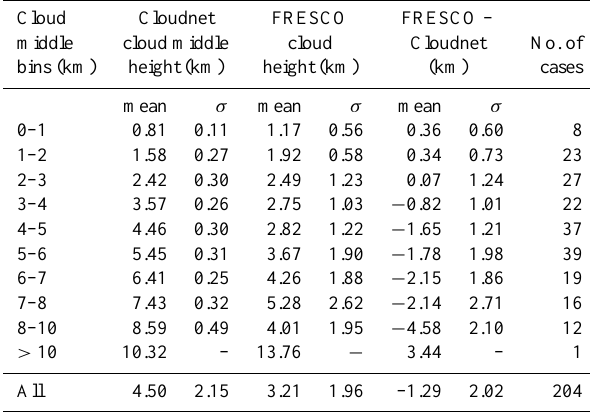
Table A7. Comparison of SCIAMACHY FRESCO cloud height with Cloudnet cloud middle layer height for multilayer clouds.